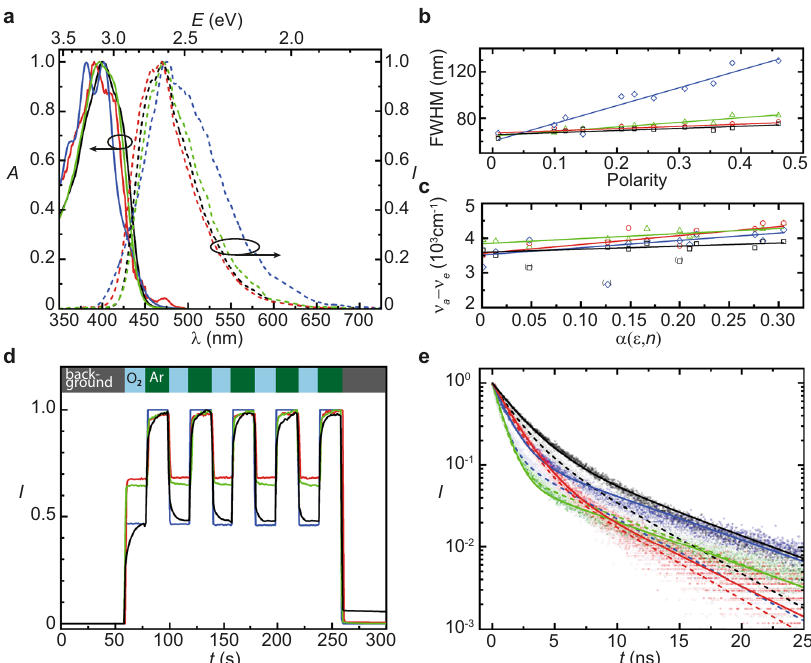
Fig. 3 Photophysical characterization. a Absorption (solid line) and emission (dashed line) spectra of MeFuPAI (blue), BeFuPAI (black), MeThPAI (green), and BeThPAI (red) in chloroform solution. Spectra in different solvents are provided in Supplementary Note 1. Black arrows indicate the corresponding ordinate. b The fl uorescence color purity, characterized by the FWHM of the emission spectrum, revealing linear dependence with the relative solvent polarity. All emitters but MeFuPAI display high color purity in polar and non-polar solvents, indicating strong LE character of the S 1 state. c Lippert – Mataga plots show linear correlation between the Stokes shift ( ν a − ν e ) and the orientational polarizability α ( ε , n ) of the solvent; data points in parentheses are treated as outliers. d Normalized emission intensity under ambient (O 2 ) and argon (Ar) atmosphere. e Time correlated single photon counting measurements of solid fi lms under argon (solid circles, solid line fi t) and oxygen (open circles, dashed line fi t) to determine the photoluminescence lifetimes. Please refer to the Supplementary Fig. 2 for individual plots of each compound. Table 1 Empirical photoluminescence data and theoretical investigation of excited state